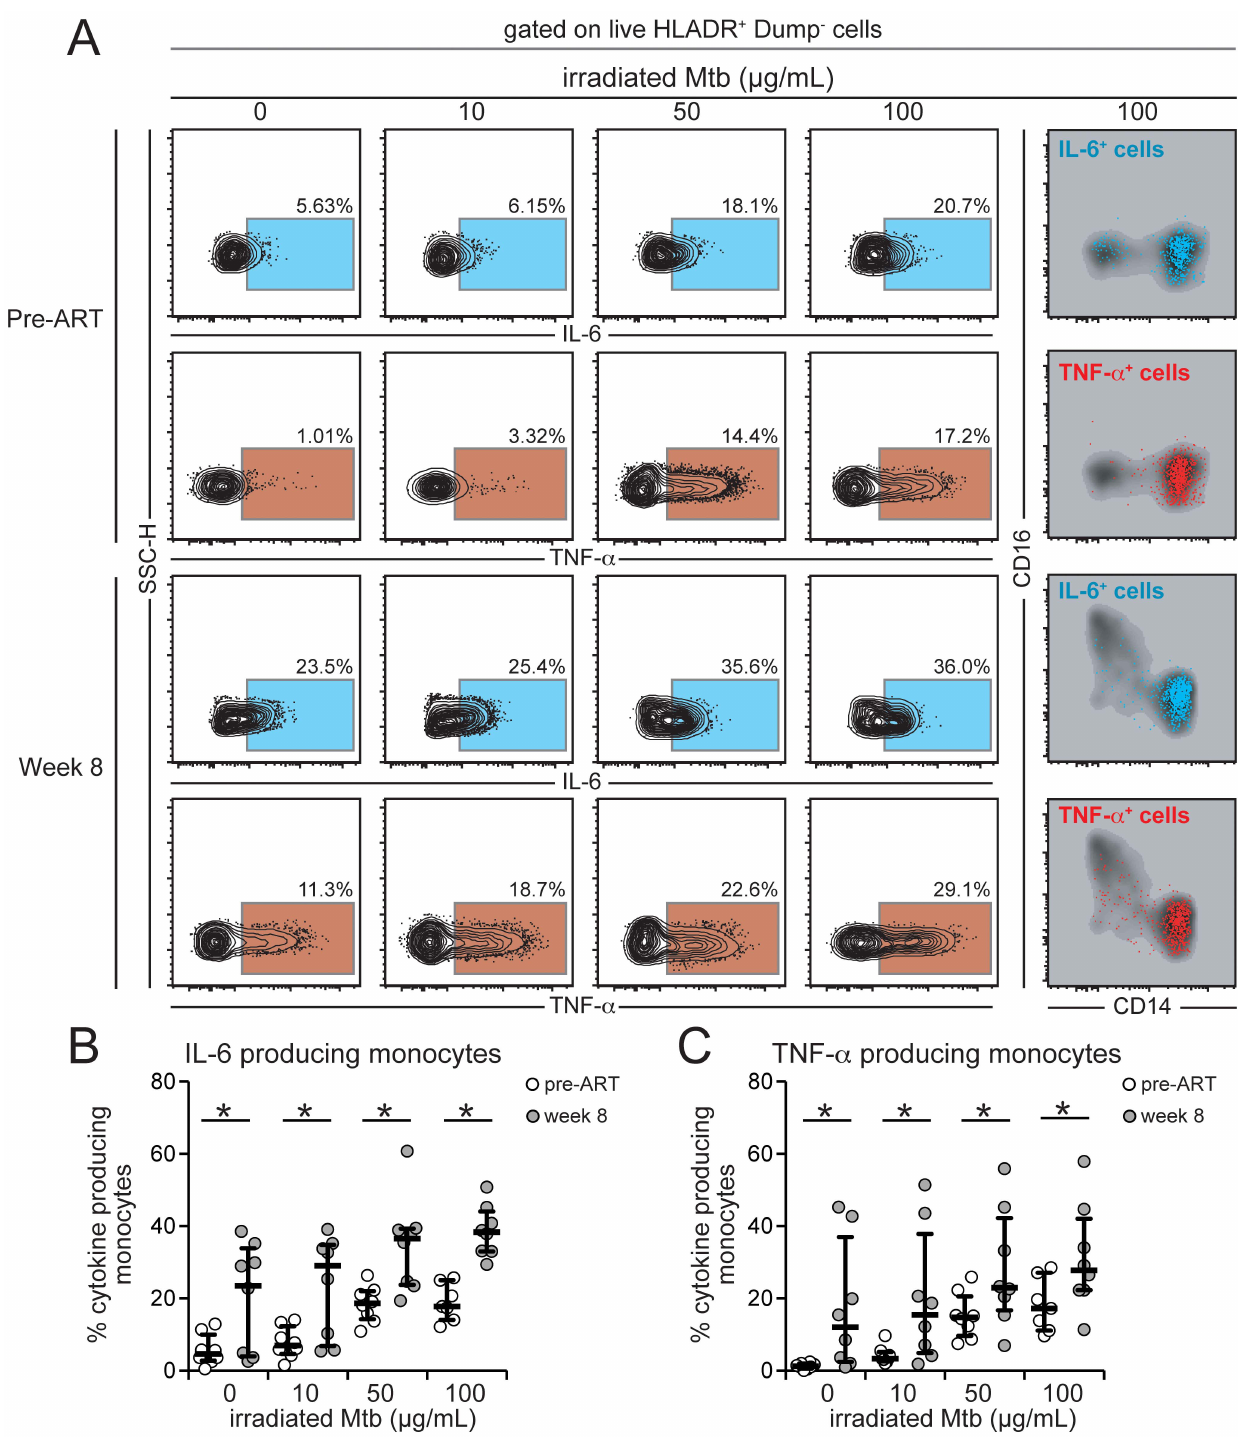
Figure 7. Intracellular production of IL-6 and TNF- a by monocytes from HIV + patients is affected by HIV plasma viremia and mycobacterial antigen load. Paired PBMC samples from eight HIV-infected individuals prior to ART initiation and after 8 weeks of treatment when patients achieved virological suppression were incubated in vitro with different doses of irradiated M. tuberculosis (Mtb) for 6 h in the presence of brefeldin-A. Intracellular cytokine assays for detection of IL-6 and TNF- a in monocytes (HLA-DR + Dump 2 cells) were performed by multicolor flow cytometry. Gates for cytokines were set up based on fluorescent minus one controls. ( A ) Representative FACS plots of percentage of monocytes expressing IL-6 or TNF- a (left panels) following stimulation with increasing doses of Mtb. Right panel shows overlays of CD14 vs. CD16 expression on cytokine-producing cells after stimulation with irradiated Mtb 100 m g/mL and reveals that most of the cytokine-producing cells in this in vitro system are CD14 ++ CD16 2 monocytes. ( B ) Percentage of monocytes from HIV + patients with high or low viral loads stained positive for intracellular IL-6 after in vitro stimulation with different doses of irradiated Mtb. Data were analyzed using the Wilcoxon matched pairs test. ( C ) Percentage of monocytes from HIV + patients with high or low viral loads stained positive for intracellular TNF- a after in vitro stimulation with different doses of irradiated Mtb. Data were analyzed using the Wilcoxon matched pairs test. * P , 0.05. doi:10.1371/journal.ppat.1004433.g007 PLOS Pathogens |